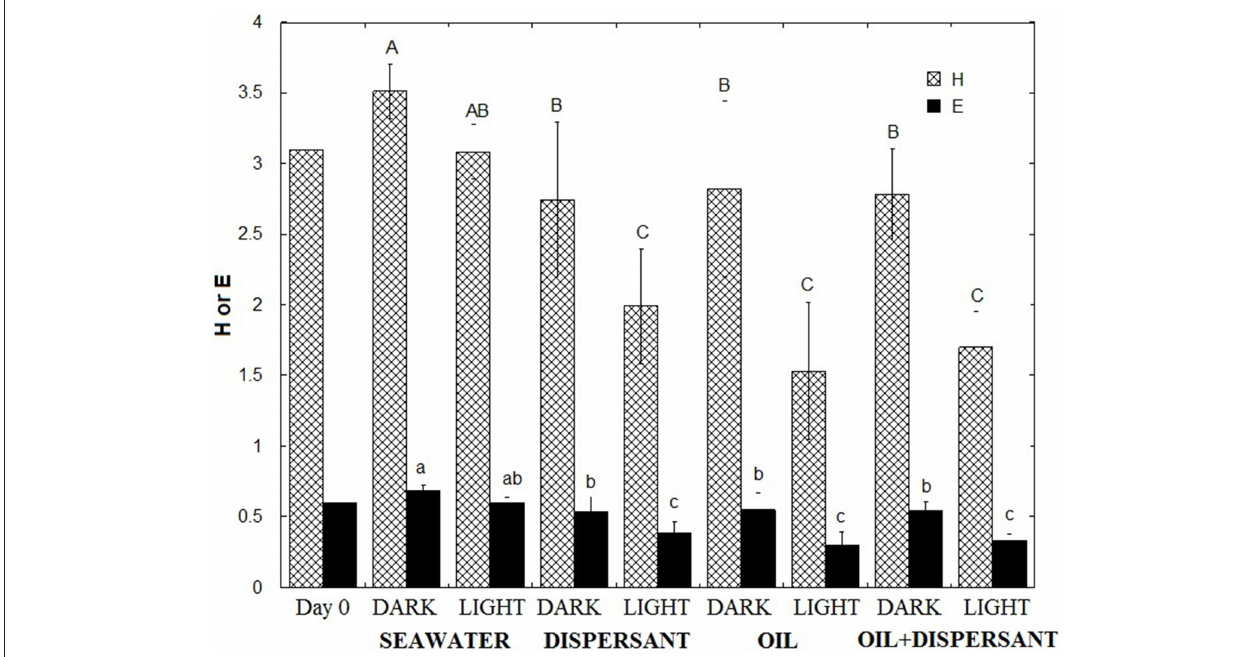
FIGURE 3 | Shannon Wiener Index (H) and Evenness (E) of microbial communities. The indices represent the average of the time series (5, 10, 20, 27, 36 days). Error bar represents the standard deviation. Different letters are significantly different ( p < 0.05 ) according to Tukey’s HSD mean separation test.